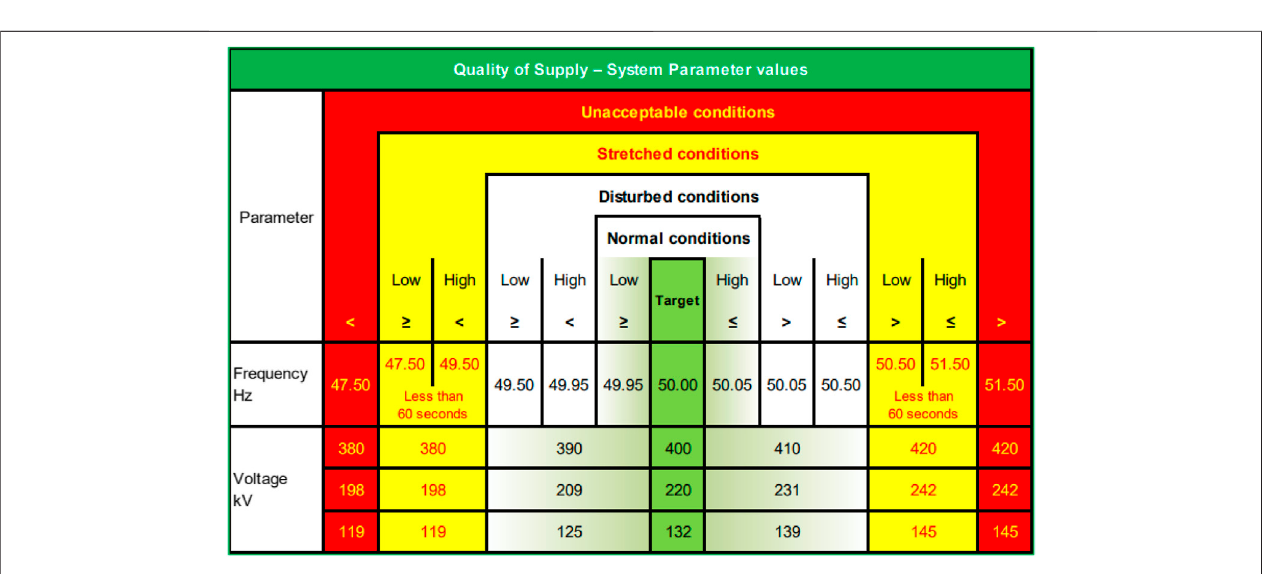
FIGURE 7 | Operational values for system